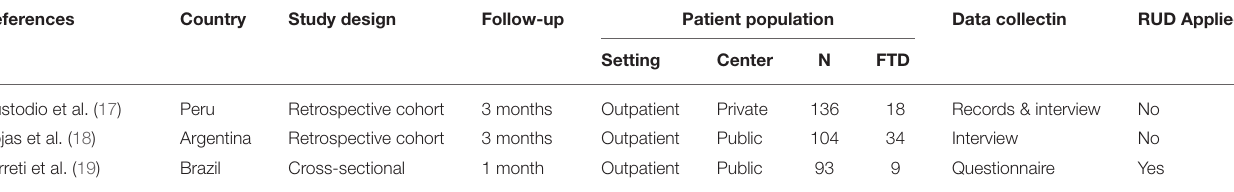
TABLE 1 | Characteristics of cost-of-illness studies in frontotemporal dementia in Latin America.